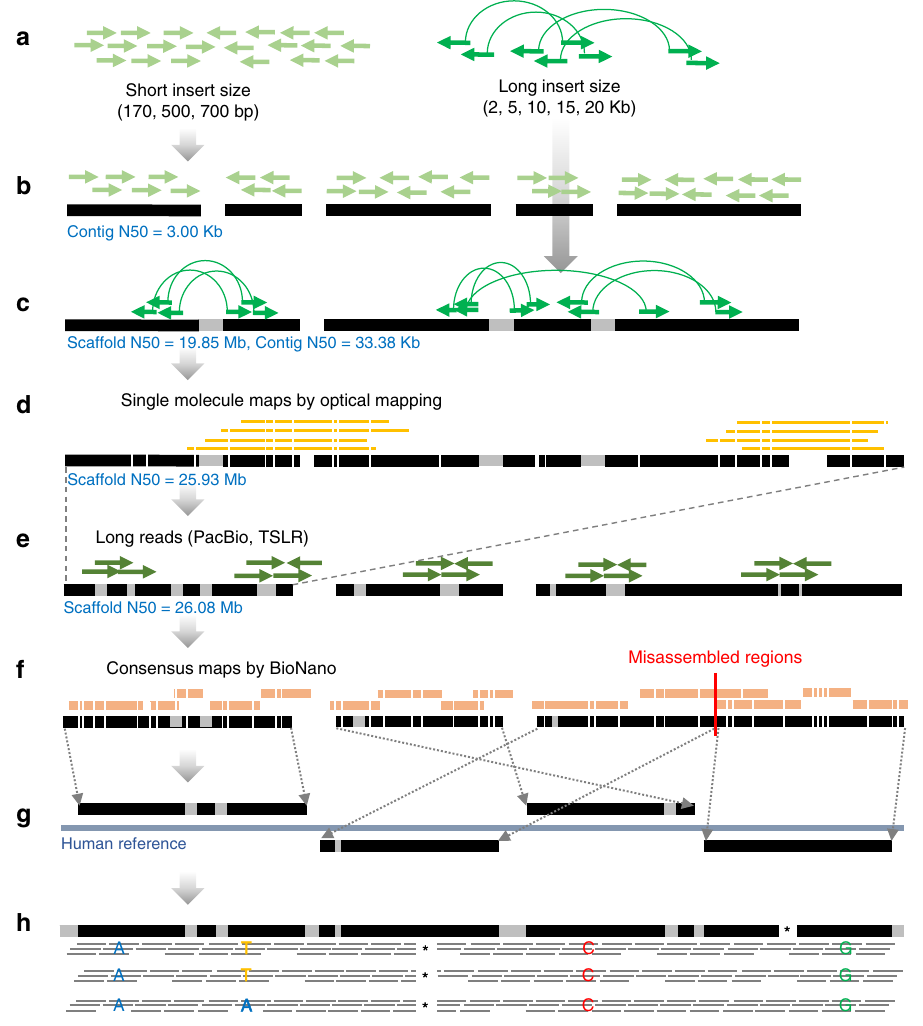
Figure 1 | Schematic overview of KOREF assembly procedure. ( a ) Short and long insert size libraries by Illumina whole-genome sequencing strategy. ( b ) Contig assembly using K -mers from short insert size libraries. ( c ) Scaffold assembly using long insert size libraries. ( d ) Super-scaffold assembly using OpGen whole-genome mapping approach. ( e ) Gap closing using PacBio long reads and Illumina TSLR. ( f ) Assembly assessment using BioNano consensus maps. ( g ) Chromosome sequence building using whole-genome alignment information into the human reference (GRCh38). ( h ) Common variants substitution using 40 Korean whole-genome Table 1 | KOREF build statistics along the assembly steps. Contig Scaffold Whole-genome optical Long reads mapping (PacBio and TSLR)